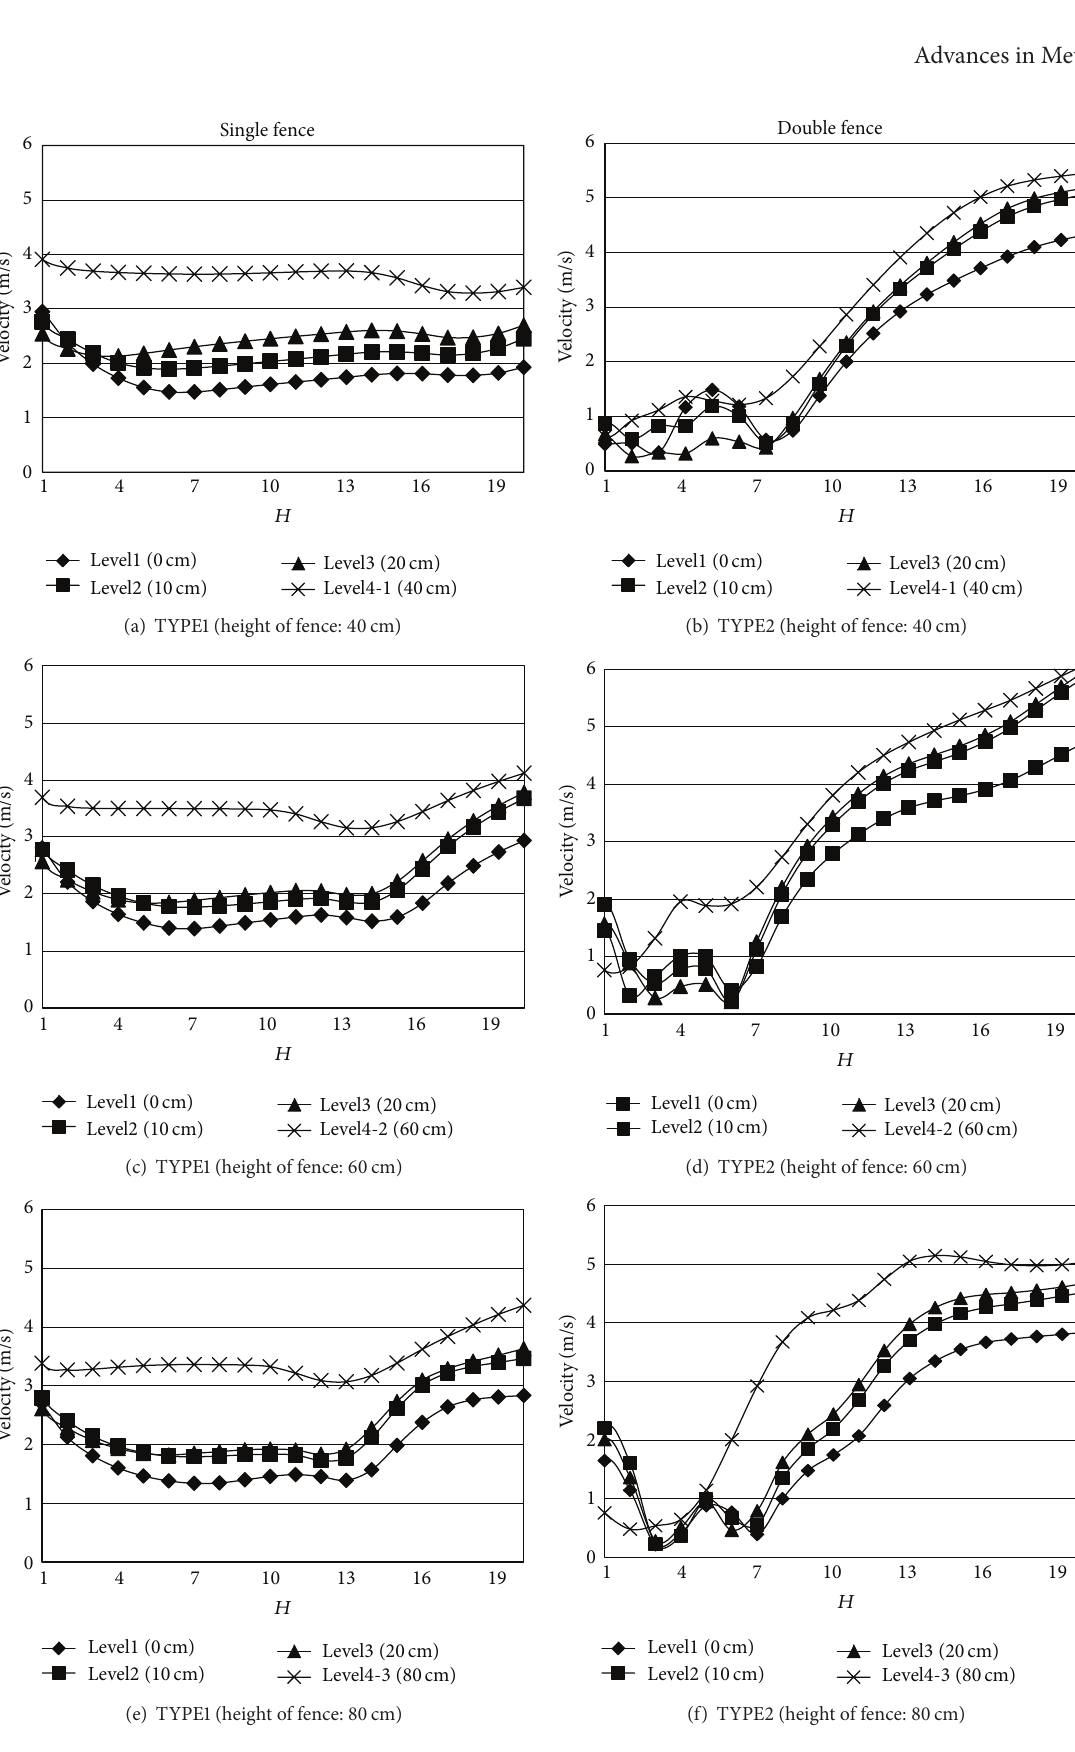
Figure 7: Wind velocity distribution of the linear windbreak fence by distance (Gap 0 cm, reference velocity = 6